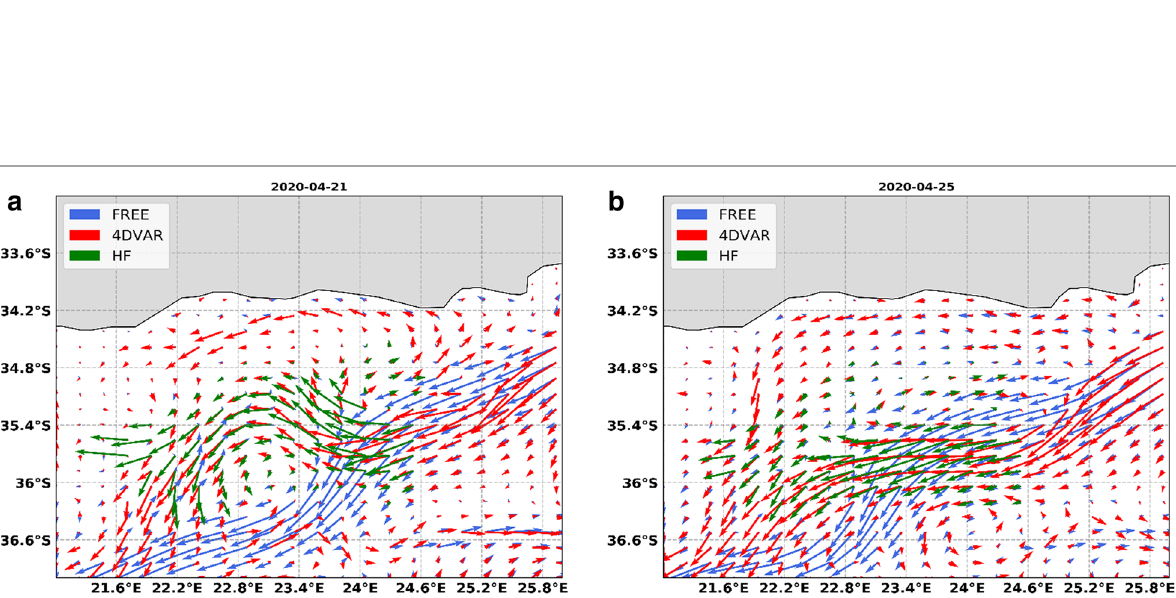
Fig. 9 Daily averaged surface currents for the first day of forecast for the 21 th and the 25 th of April 2020. Blue arrows correspond to the FREE experiment. Red arrows correspond to the forecast and the green arrows correspond to the HF radar measured